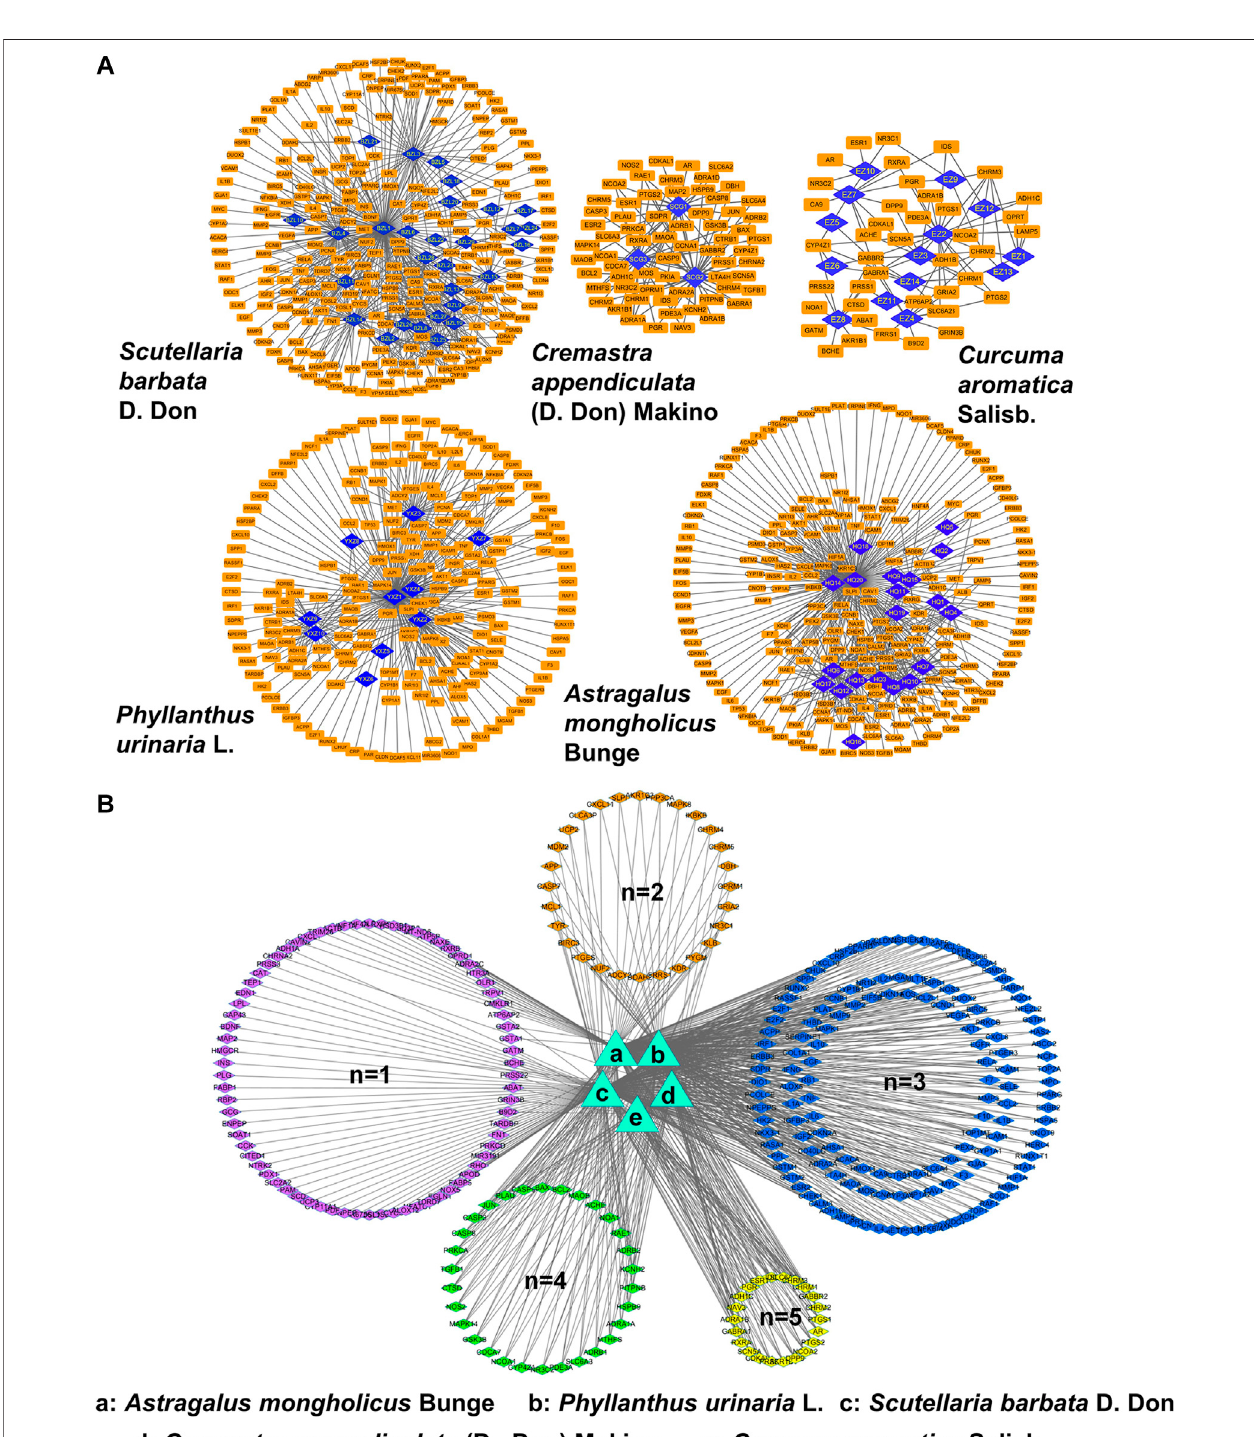
FIGURE 4 | Network pharmacology analysis of CP. (A) Ingredient-target networks of the fi ve herbs of CP. There are 29 major ingredients in Scutellaria barbata D. Don, three in Cremastra appendiculata (D. Don) Makino, 14 in Curcuma aromatica Salisb., 10 in Phyllanthus urinaria L. and 20 in Astragalus mongholicus Bunge. (B) Common targets networks of CP. 76 were common targets of one herb, 28 were common targets of two herbs, 142 were common targets of three herbs, 30 were common targets of four herbs and 22 were common targets of fi ve herbs.